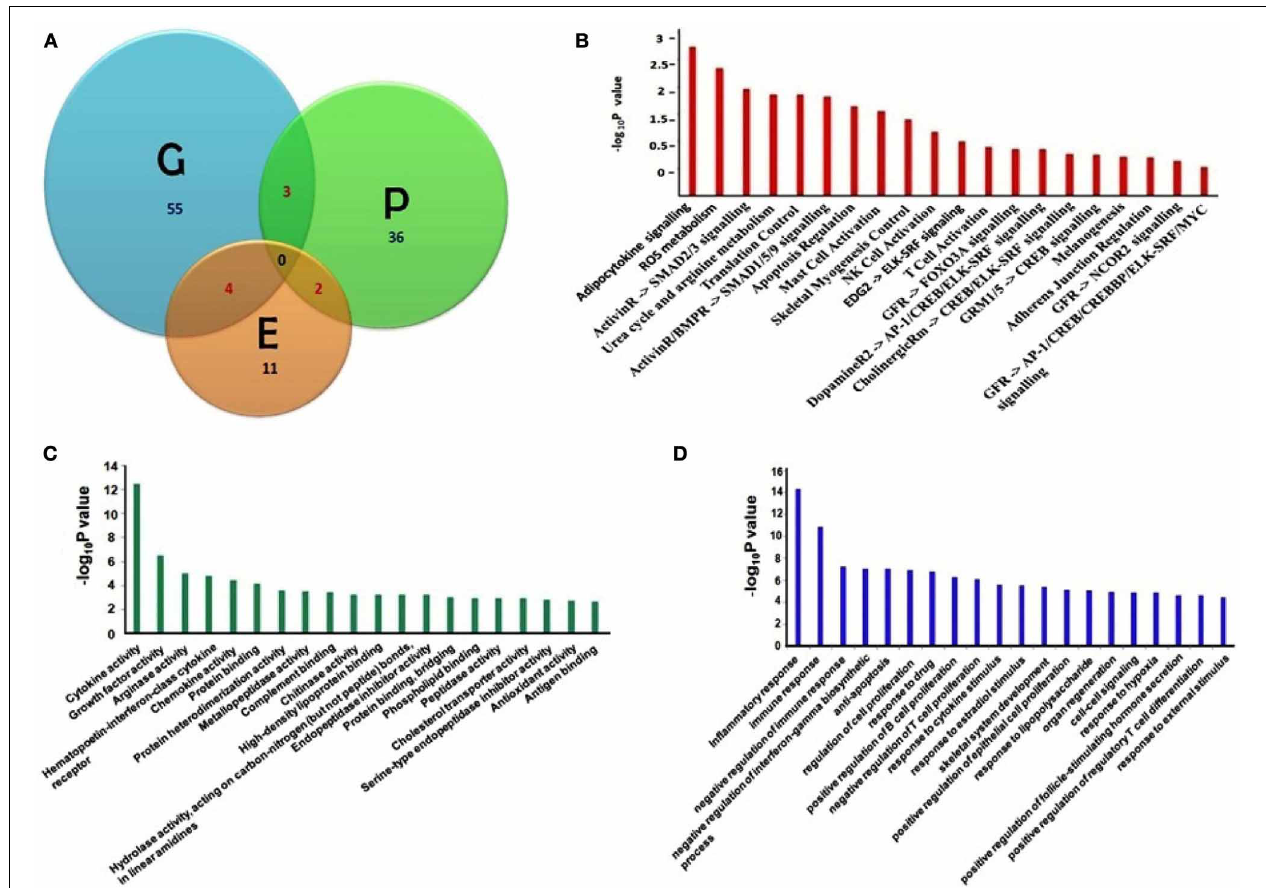
FIGURE 1 | (A) Venn diagram showing asthma biomarkers identified in three different approaches of Genomics [G], Proteomics [P] and Epigenetic [E] studies with overlaps among the intersects. (B) Significant pathways; (C) enriched gene ontology molecular functions, and (D) biological function